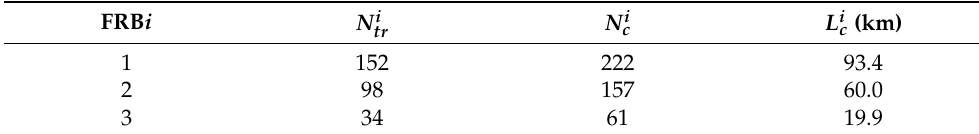
Table 1. Summary of the power distribution network infrastructure in Frederiksberg. For each FRB i , there are N i transformers connected to N i c cables covering a total length L i c . tr